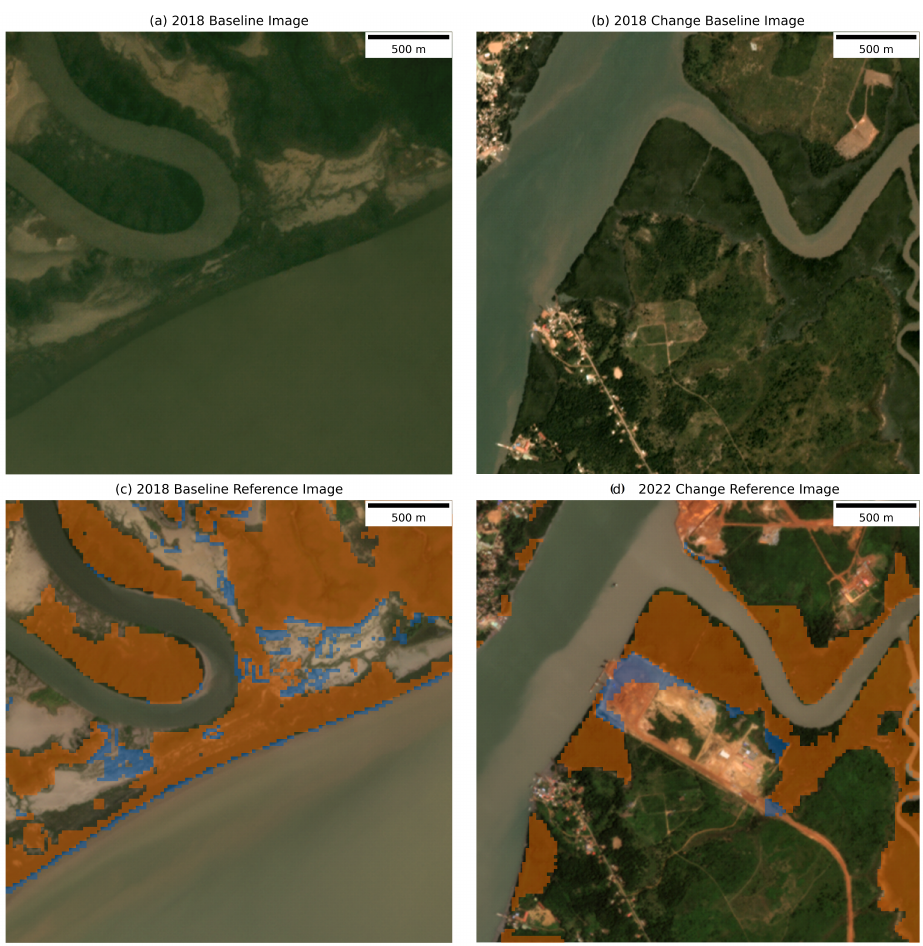
Figure 3. Examples of the reference images defined for the sensitivity analysis for identifying the baseline thresholds (( c ); Table 1) and the change thresholds (( d ); Table 2). ( a , b ) illustrate the 2018 Planet imagery for the area while ( c ) mangroves that should be within the 2018 baseline (orange) and pixels which should be removed from the mangrove mask by the thresholding (blue). ( d ) Mangroves that have not been lost (orange) or lost (blue) between 2018 and 2022. (Image courtesy: Planet